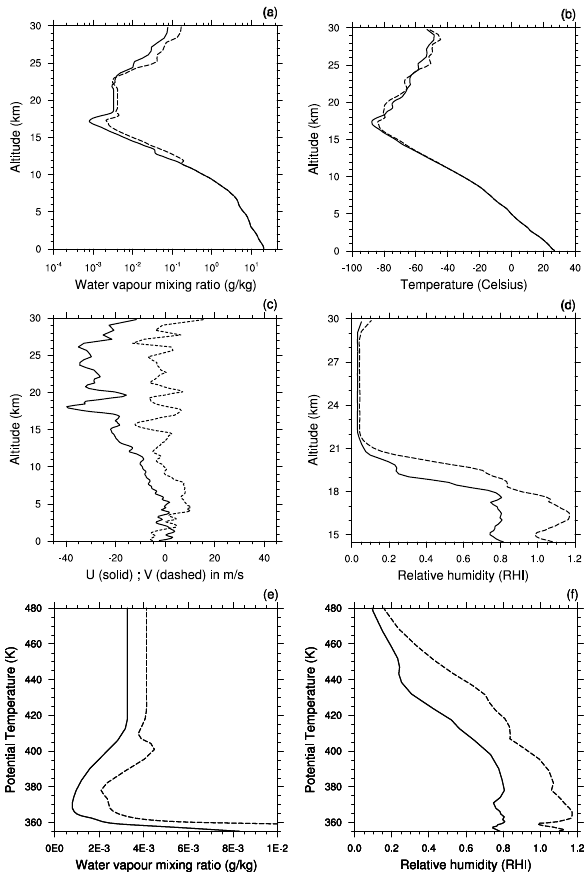
Figure 1: Background profiles used to initialise the simulations. (a) water vapour, (b) temperature, (c) zonal (U) and meridional (V) wind, (d) relative humidity with respect to ice (RHI) versus altitude. (e) Water vapour and (f) RHI are versus potential temperature ( θ ) levels spanning 355–480 K, corresponding to the altitude range of ∼ 14.5–20.5 km. With the exception of (c) , the solid lines correspond to profiles derived from the Darwin (SUBSAT) sounding and the dashed lines correspond to profiles derived from the Mount Bundy (SUPERSAT) sounding.